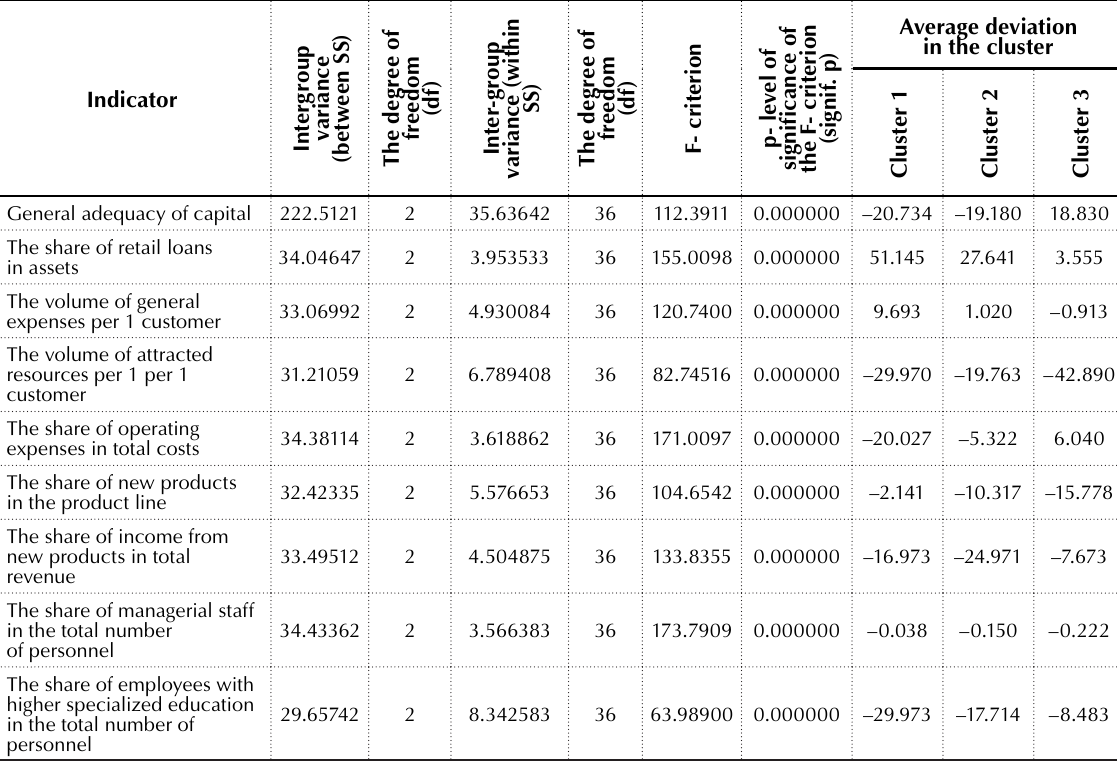
Table 3. Characteristics of clusterization and mean values of deviations of comparable indicators from the reference values (for banks at the stage of intensive growth)